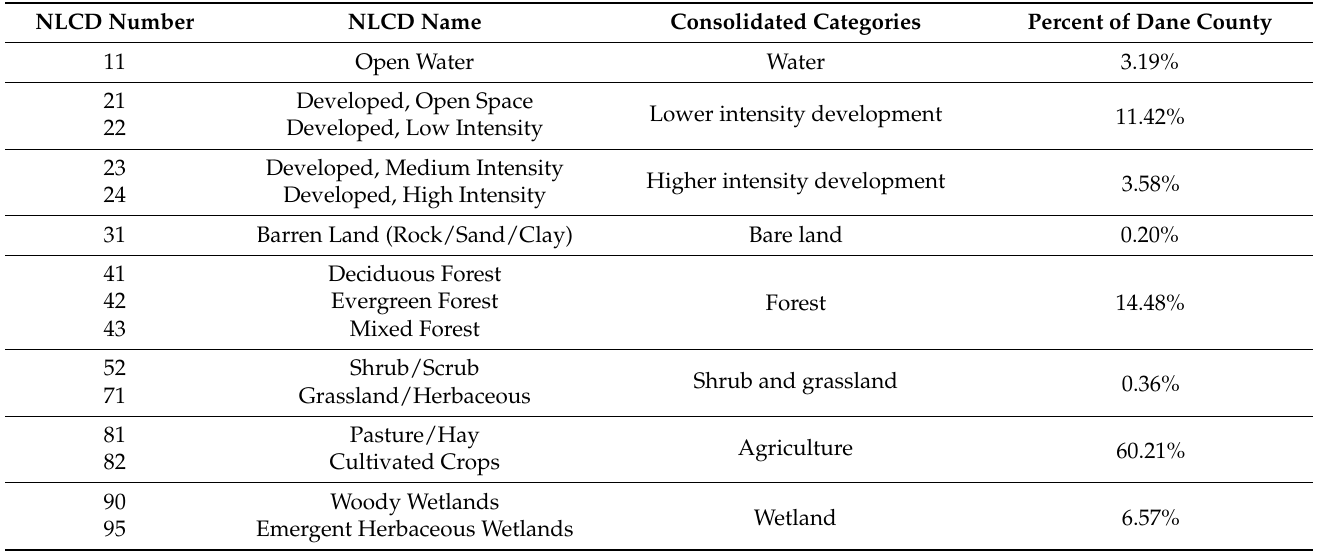
Table 2. Original NLCD classes and consolidated land cover categories used in the land cover